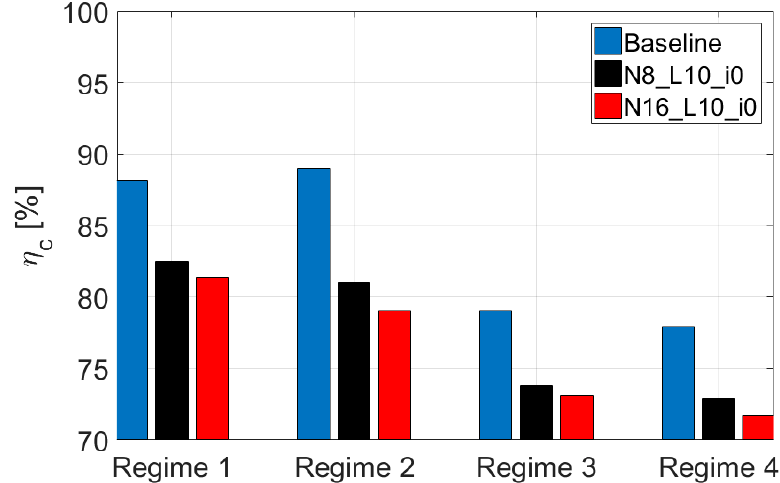
Figure 10. Variation of the compressor efficiency depending on the regime and nozzle type.